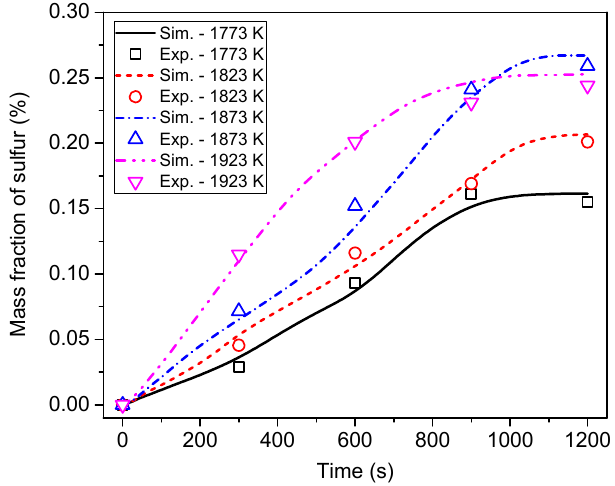
Figure 9. Variation of mass fraction of sulfur at point 2 in molten manganese over time.